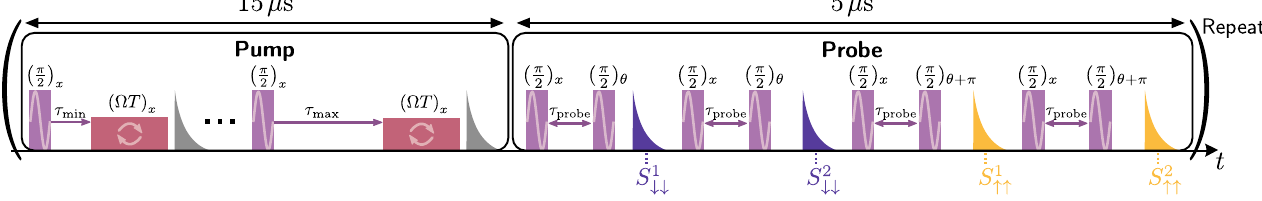
FIG. 8. Experimental pulse sequence. A schematic of the ESR control pulses (pink and red square pulses) and readouts (gray, purple, and yellow spin-pumping transients) that make up a single repeating block of the entire experiment (timings not to scale). The purple and yellow spin-pumping transients correspond to reading out opposite electronic spin populations, achieved with a relative π phase shift on the second Ramsey gate ð π = 2 Þ θ . The phase of the second Ramsey gate is serrodyned at a frequency ω þ π